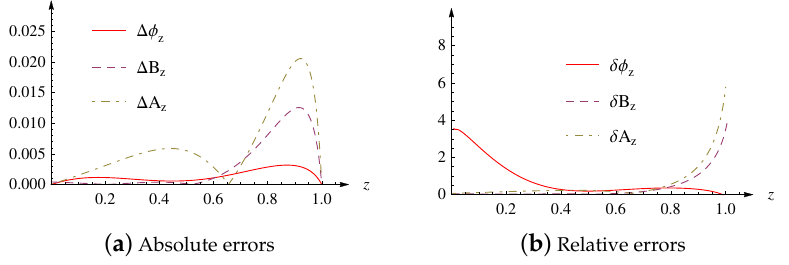
Figure 5. Absolute and relative errors between numerical and analytical approximate